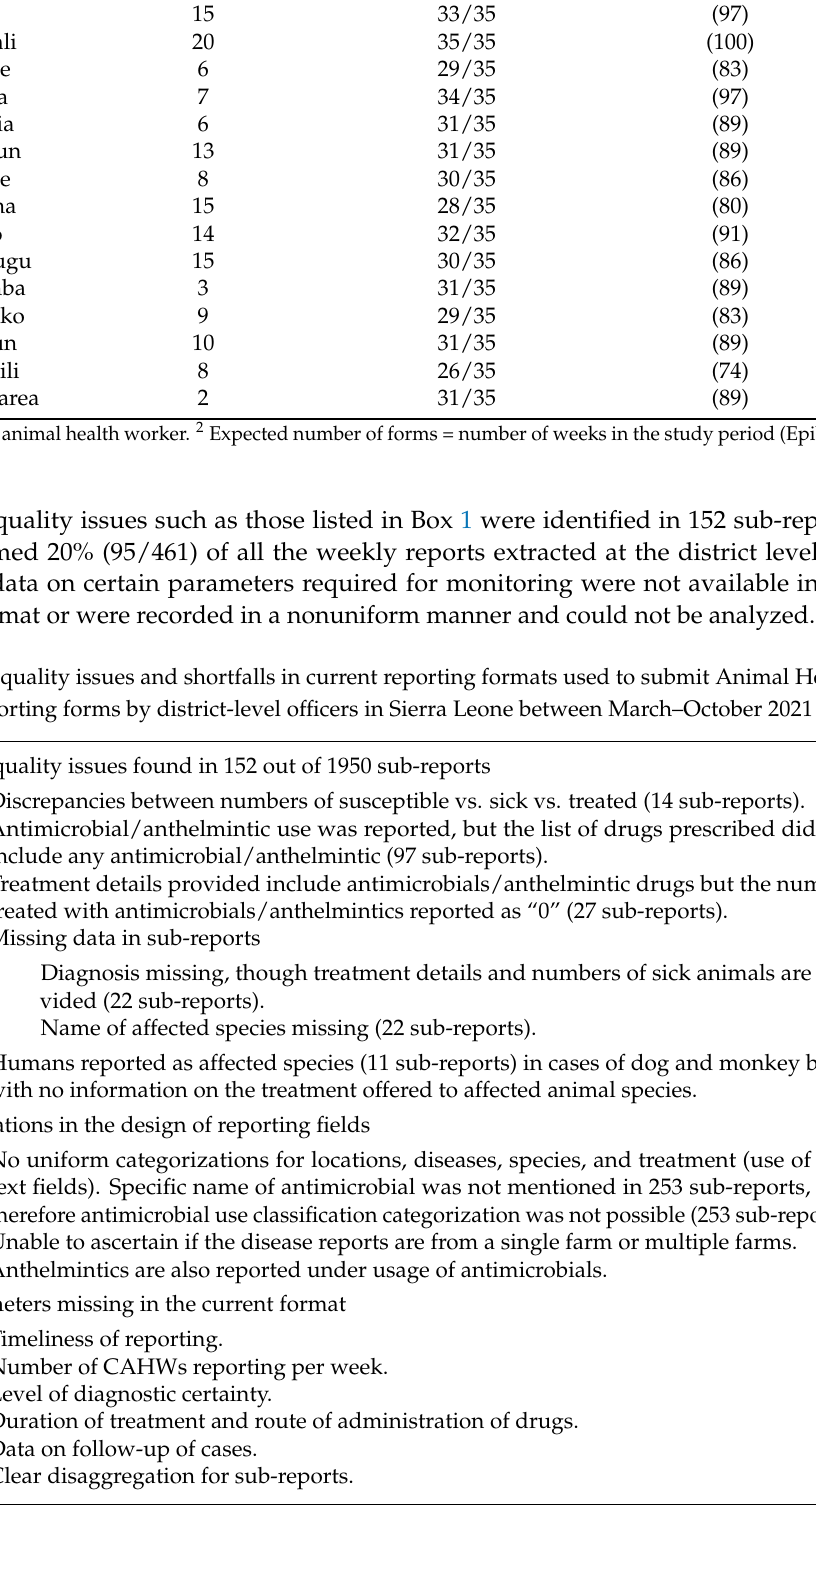
District Number of CAHWs